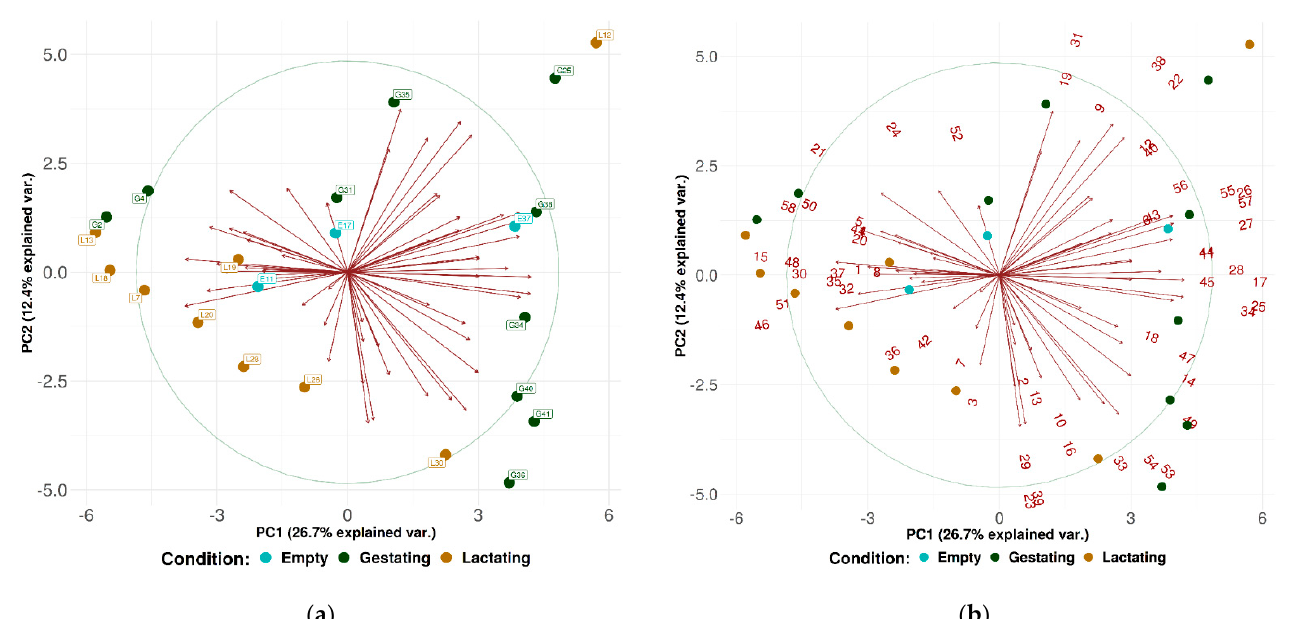
Figure 3. ( a ). Principal component analysis (PCA) characterizing the oral fluid bacterial microbiota of sows. Plot illustrating the distribution of the samples ( n = 22) in the main two axes. ( b ) Principal component analysis (PCA) characterizing the oral fluid bacterial microbiota of sows. Plot illustrating the distribution of the main genera ( n = 58) in the main two axes.